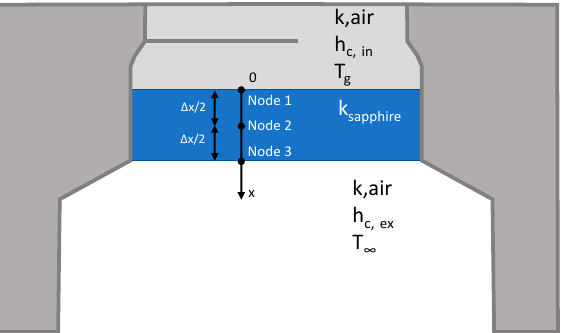
Figure 5. Scheme of the 1D model and fluids/material properties used as input of the piston window model.